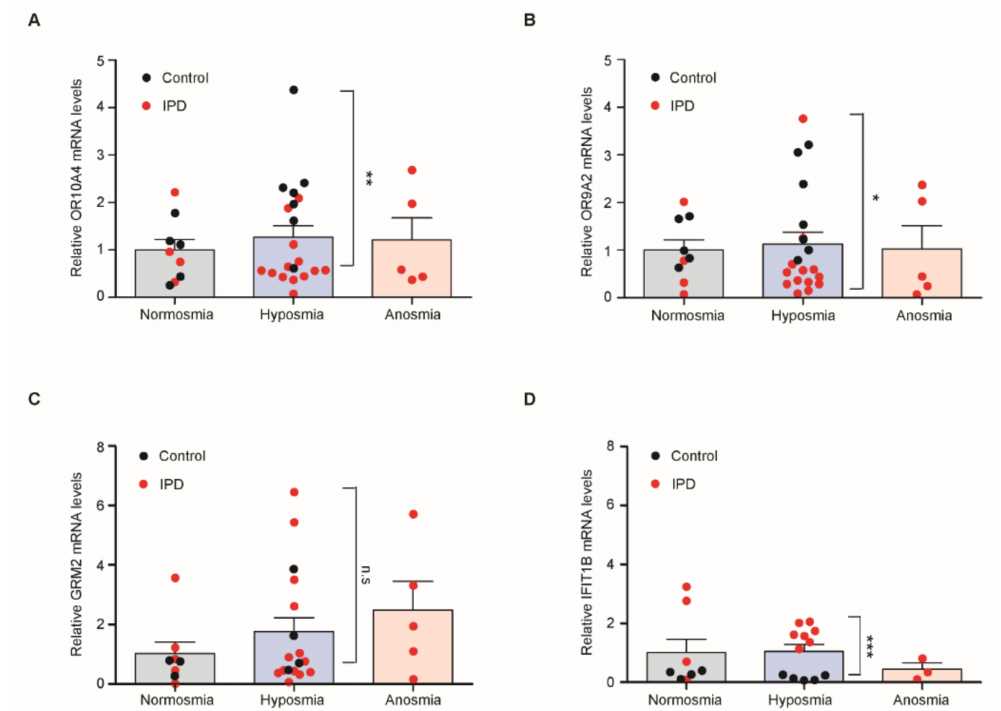
Figure 4. Analysis of nasal transcripts between normosmia, anosmia, and hyposmia cases in the PD and control groups. ( A ) Relative nasal OR10A4 transcript levels in three groups of di ff erent olfactory statuses ( n = 9 normosmia, 20 hyposmia, and 5 anosmia). PD and controls are expressed as red and black filled circles ( n = 12 con and 22 PD), respectively. ( B ) Relative nasal OR9A2 transcript levels in three groups of di ff erent olfactory statuses ( n = 9 normosmia, 20 hyposmia, and 5 anosmia). PD and controls are expressed as red and black filled circles ( n = 12 con and 22 PD), respectively. ( C ) Relative nasal GRM2 transcript levels in three groups of di ff erent olfactory statuses ( n = 8 normosmia, 17 hyposmia, and 5 anosmia). PD and controls are expressed as red and black filled circles ( n = 7 con and 23 PD), respectively. ( D ) Relative nasal IFIT1B transcript levels in three groups of di ff erent olfactory statuses ( n = 8 control, 12 hyposmia, and 3 anosmia). PD and controls are expressed as red and black filled circles ( n = 9 con and 14 PD), respectively. The data are expressed as the mean ± SEM. Statistical comparison was done for the hyposmia cases in the PD and control groups. * p < 0.05, ** p < 0.01, and *** p < 0.001. n.s,